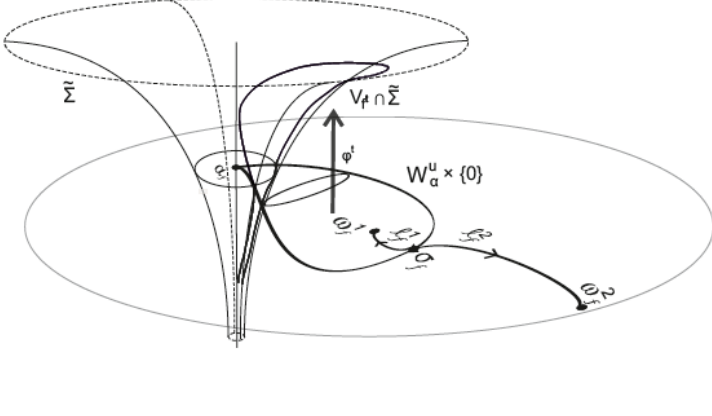
Fig. 4 The vector field and ˜ Σ on S 3 ×